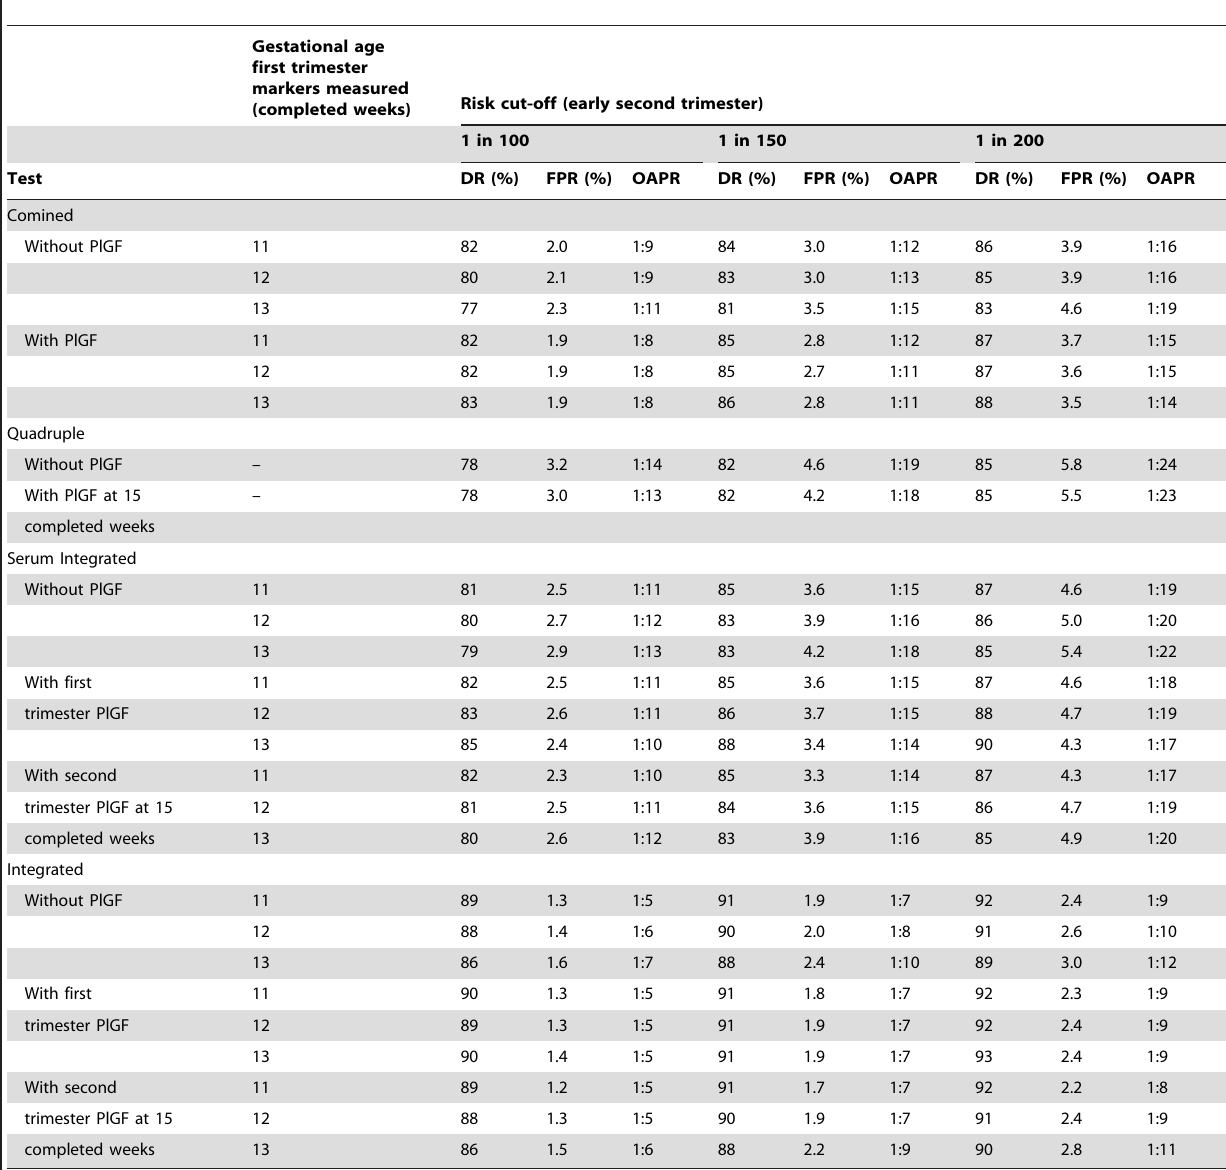
Table 4. Screening performance according to risk cut-off of the Combined, Quadruple and Integrated tests with and without the addition of first or second trimester placental growth factor (PlGF) according to gestational age markers are measured.